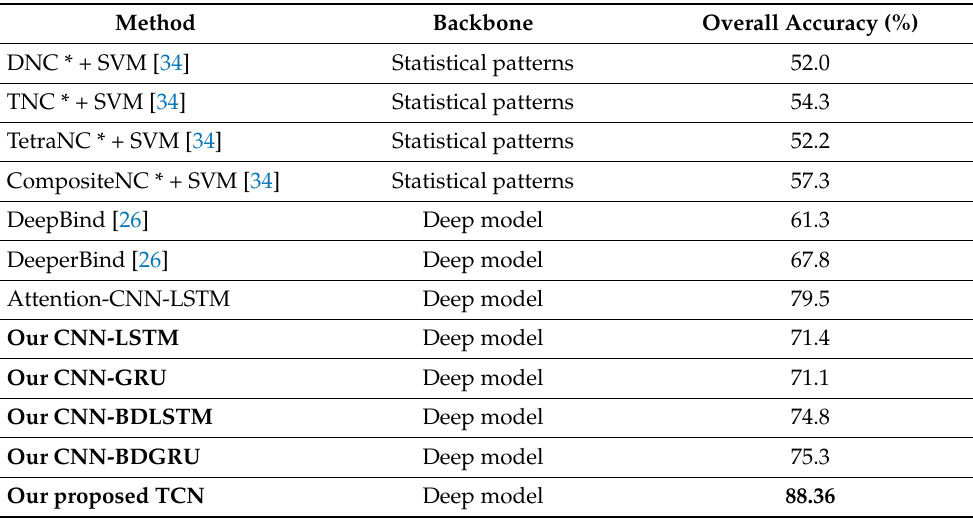
Table 1. Details of ablation study and comparative analysis of the proposed framework with existing techniques. (*) represents the implementation of the methods is done by our